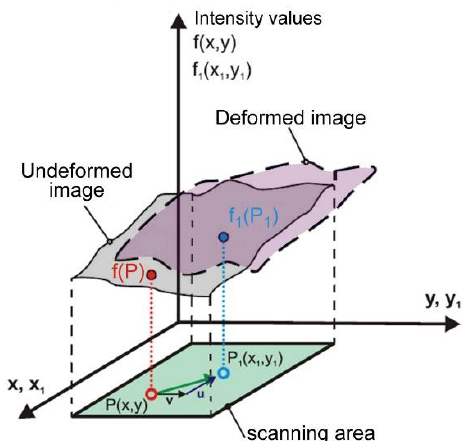
Figure 3. Diagram of surface image analysis before and after deformation [34].